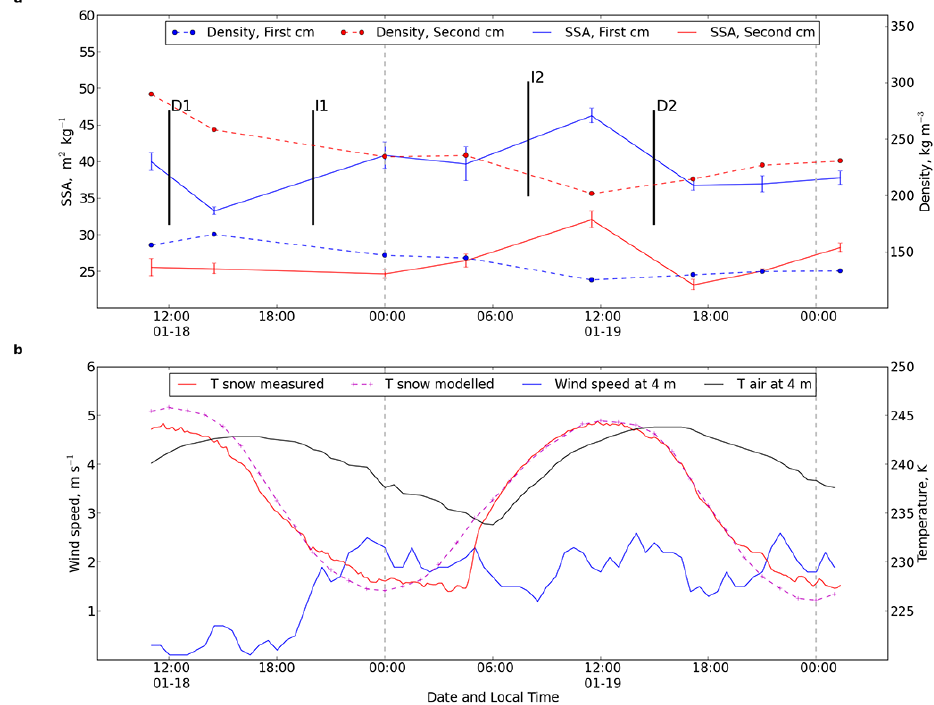
Figure 2. Time series of physical variables on 18 and 19 January 2009. Time is local time, GMT + 08:00. (a) Snow SSA and density values. (b) Meteorological variables and simulated temperature with Crocus. Date is indicated in the lowest part of the x axis and local time just above. Table 2. Possible regimes for water vapor exchange as a function of environmental conditions for an unsaturated atmosphere. This table is adapted from the Table 1 of Style and Worster